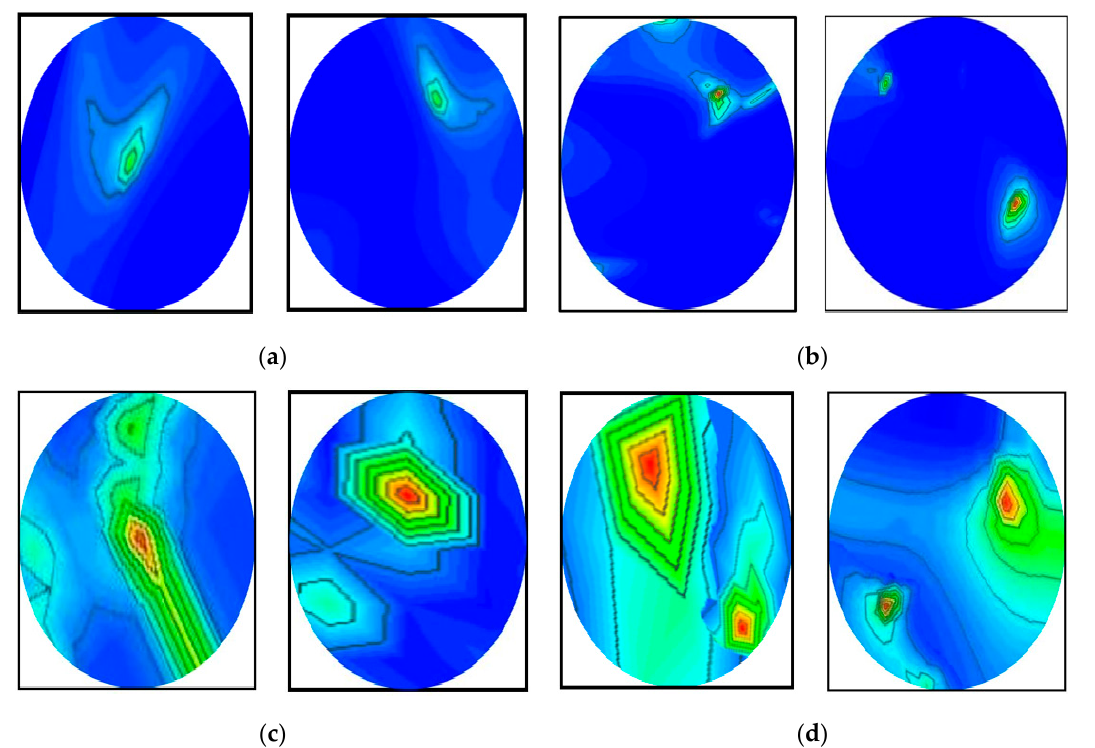
Figure 16. Some misclassified images by the BINet model for the raw RMW images: ( a ) non-tumor images were misclassified as a single tumor class, ( b ) single tumor images were misclassified as a non-tumor class, ( c ) single tumor images were misclassified as a double tumor class, and ( d ) double tumor images were misclassified as a single tumor class.